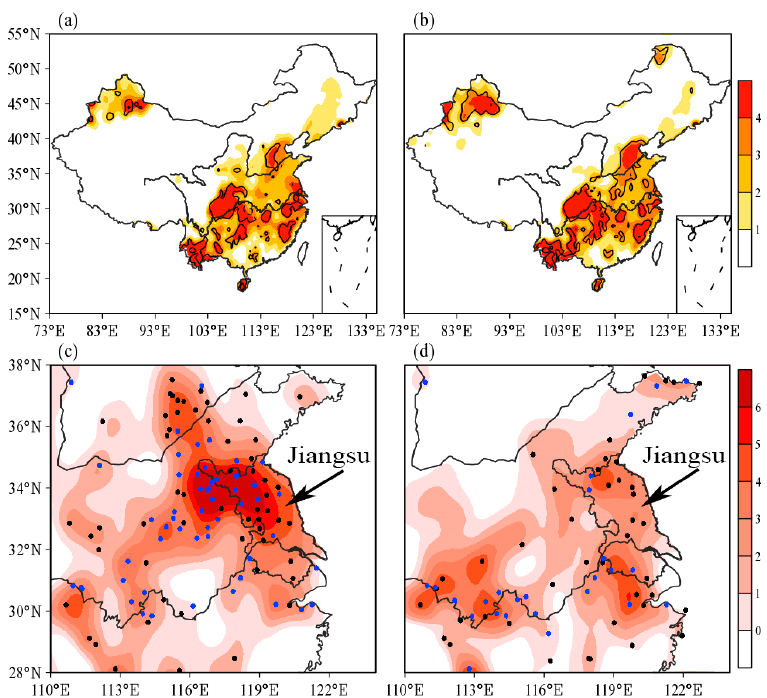
Figure 2. ( a ) The climatological fog days in November averaged from 1961 to 2017 (shaded) in China. Standard deviations exceeding 3.0 days are marked by contours; ( b ) as in ( a ), but for December; ( c ) the anomalous fog days (shaded) and the stations that anomalies exceeding 2.0 (black dots)/3.0 (black dots) standard deviations in November 2018 in China; ( d ) as in ( c ), but for December. The units of all shaded and contours are days. The two lines on the China map are the Yellow River (line in the northern) and Yangtze River (line in the southern). The boundary of Jiangsu Province, China is marked in ( c , d ).